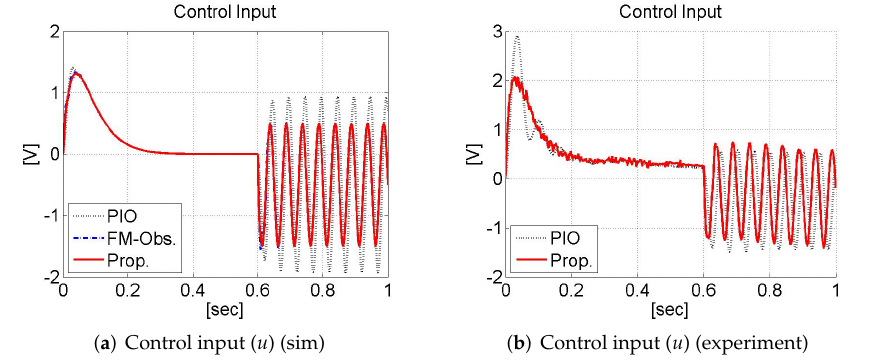
Figure 8. Results of control